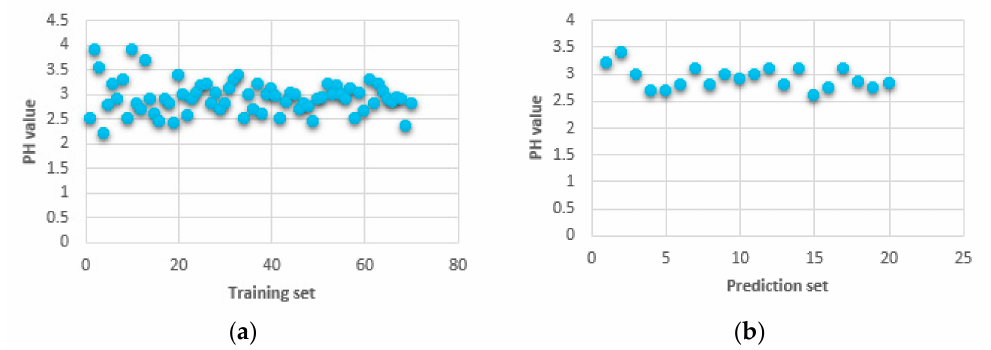
Figure 5. Scatter plot of pH of two sets: ( a ) scatter plot of the training set, ( b ) scatter plot of the prediction set.